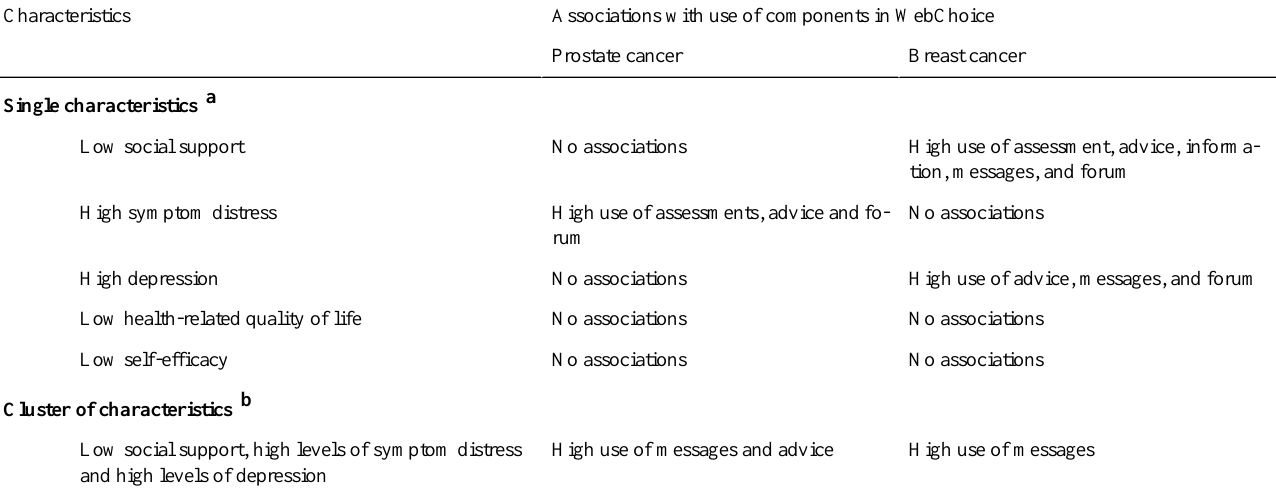
Table 6. Summary of associations among single patient characteristics or a cluster of patients’ characteristics and use of components in WebChoice stratified by